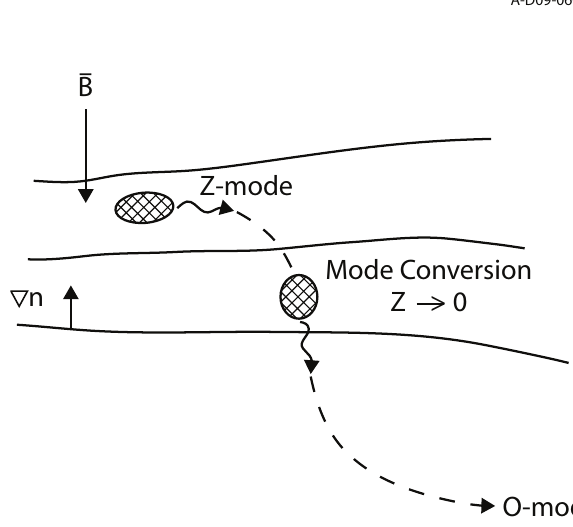
Fig. 8. Maximum Z-mode growth rate (relative to (cid:127)) versus ω p / (cid:127) . The growth rate is greatly enhanced when ω p / (cid:127) assumes values defined by Eq. (4) of the text.